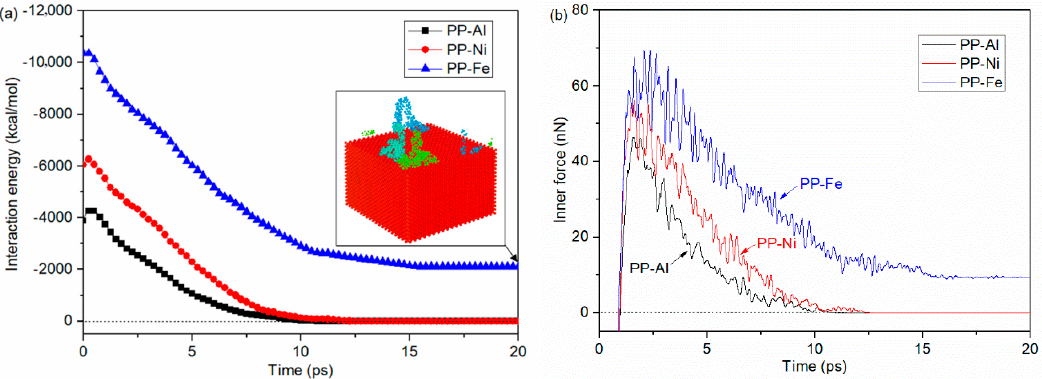
Figure 10. Radii of gyration in PP layer during the separation process with different substrate structures. The radius of gyration is calculated for ( a ) the whole PP layer and ( b ) molecular chains at the interface that are obviously stretched during the separation.